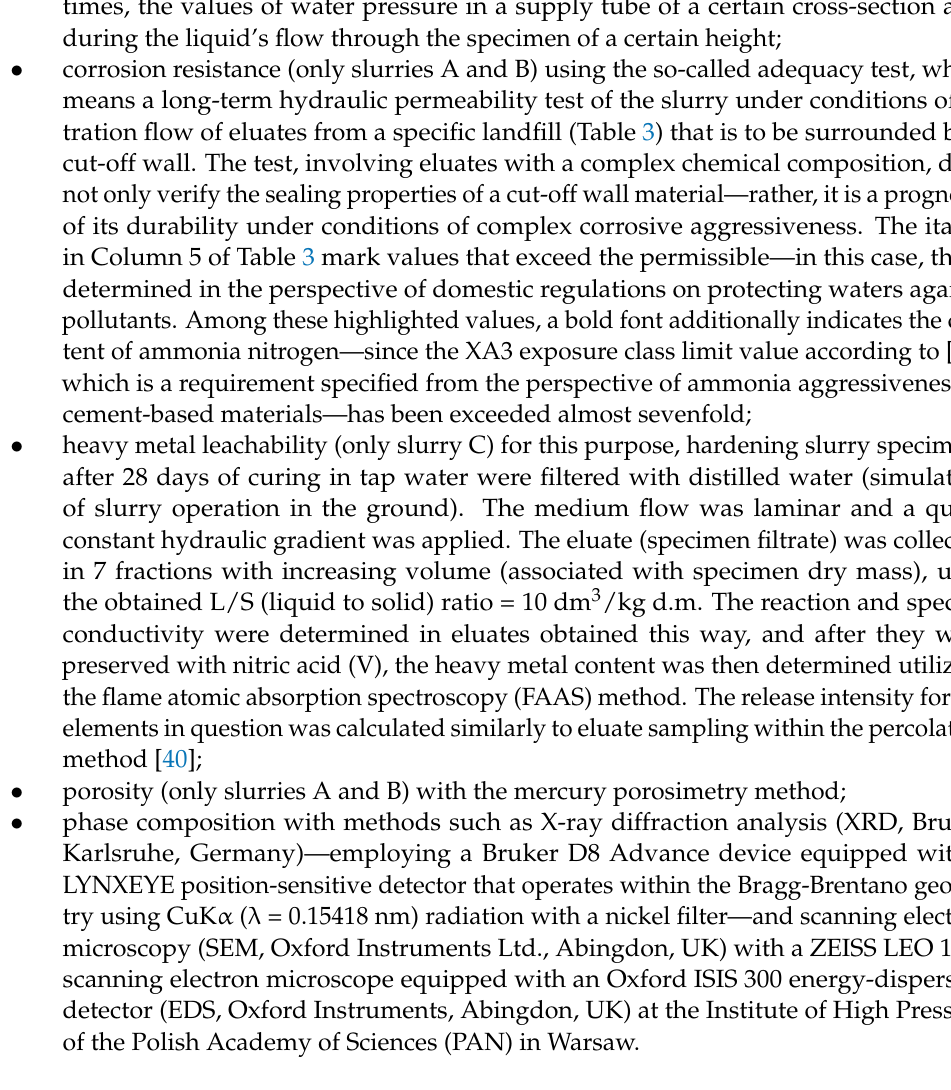
Table 3. Physical and chemical parameters of municipal landfill eluates and values permitted by legal regulations [41].